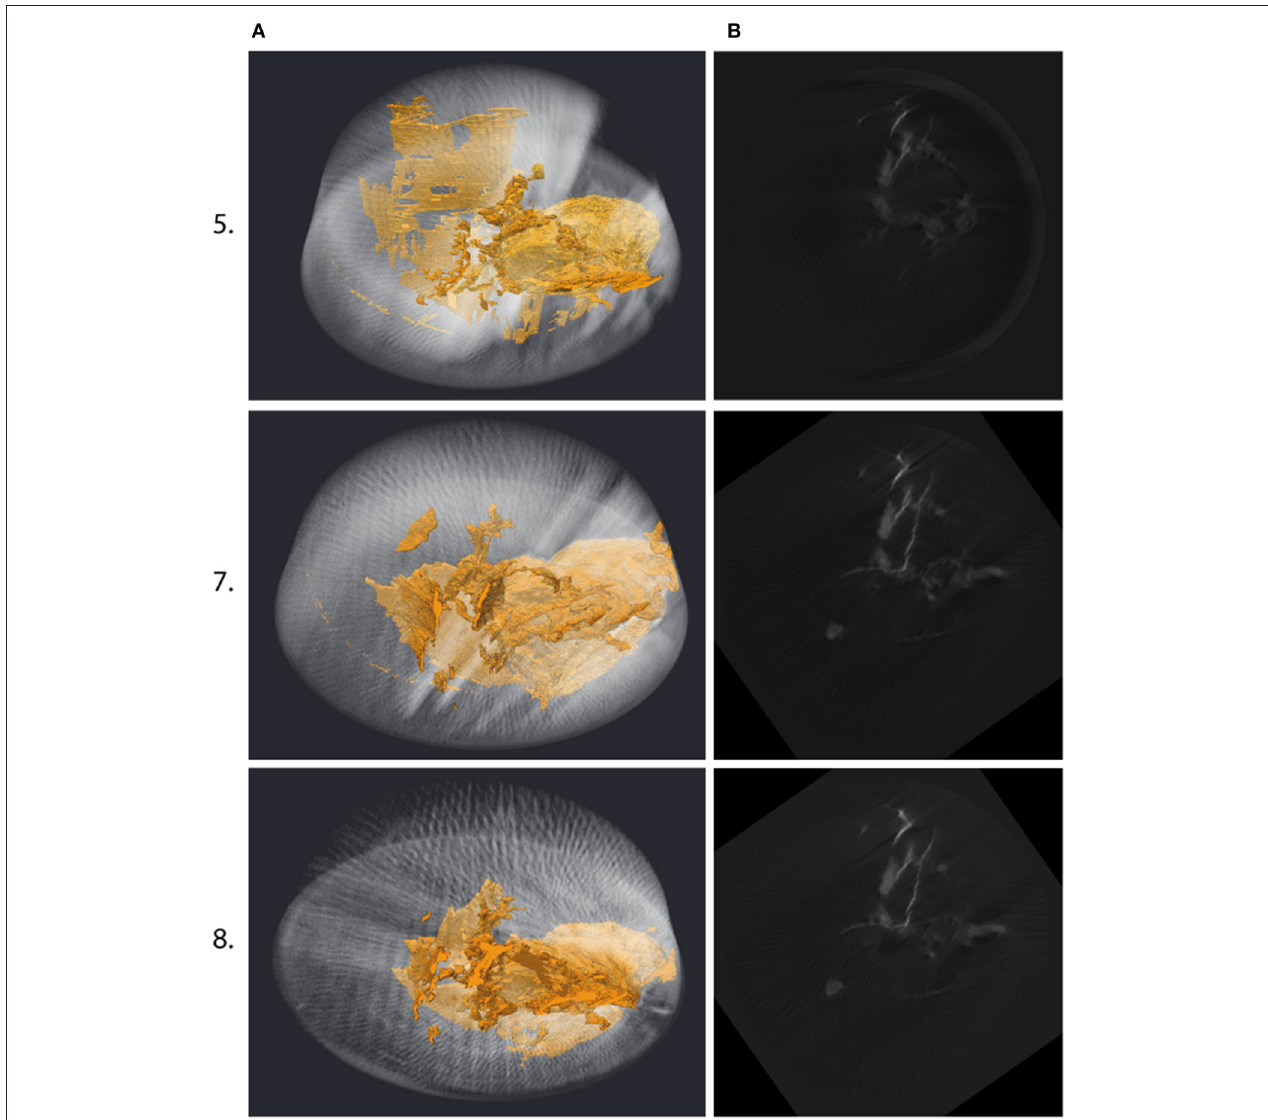
FIGURE 4 | (A) Whole volume renderings for scans 5, 7, and 8 (shown in Figure 3 ) oriented to show a basal perspective of the sample volume. Au melt shown in gold, and h-BN capsule in transparent white for reference. mm-wide, 10 1 µ m thick melt sheets with a vertical to near vertical orientation are evident. (B) Corresponding 2D reconstructions from close to the base of the sample volume, showing both permeating melt sheets (fuzzy white) and linear fracture-like sheets. Numbers on vertical axis refer to scan numbers. There is a significant change between scans 5 and 7 due to extensive melt accumulation at the base of the capsule, and some melt loss out of the sample volume. Several melt features evident in 5 are absent in 7, presumably as melt has drained away. In contrast, there is minimal evidence for additional fracturing between scans 7 and 8, as discussed in the main text.